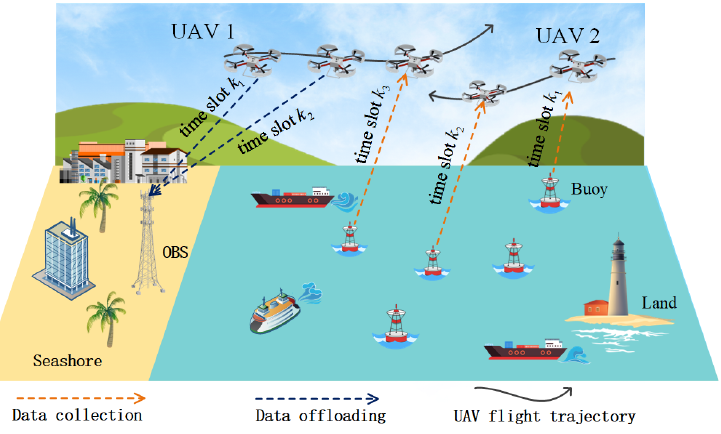
Figure 1. The UAV-assisted maritime IoT